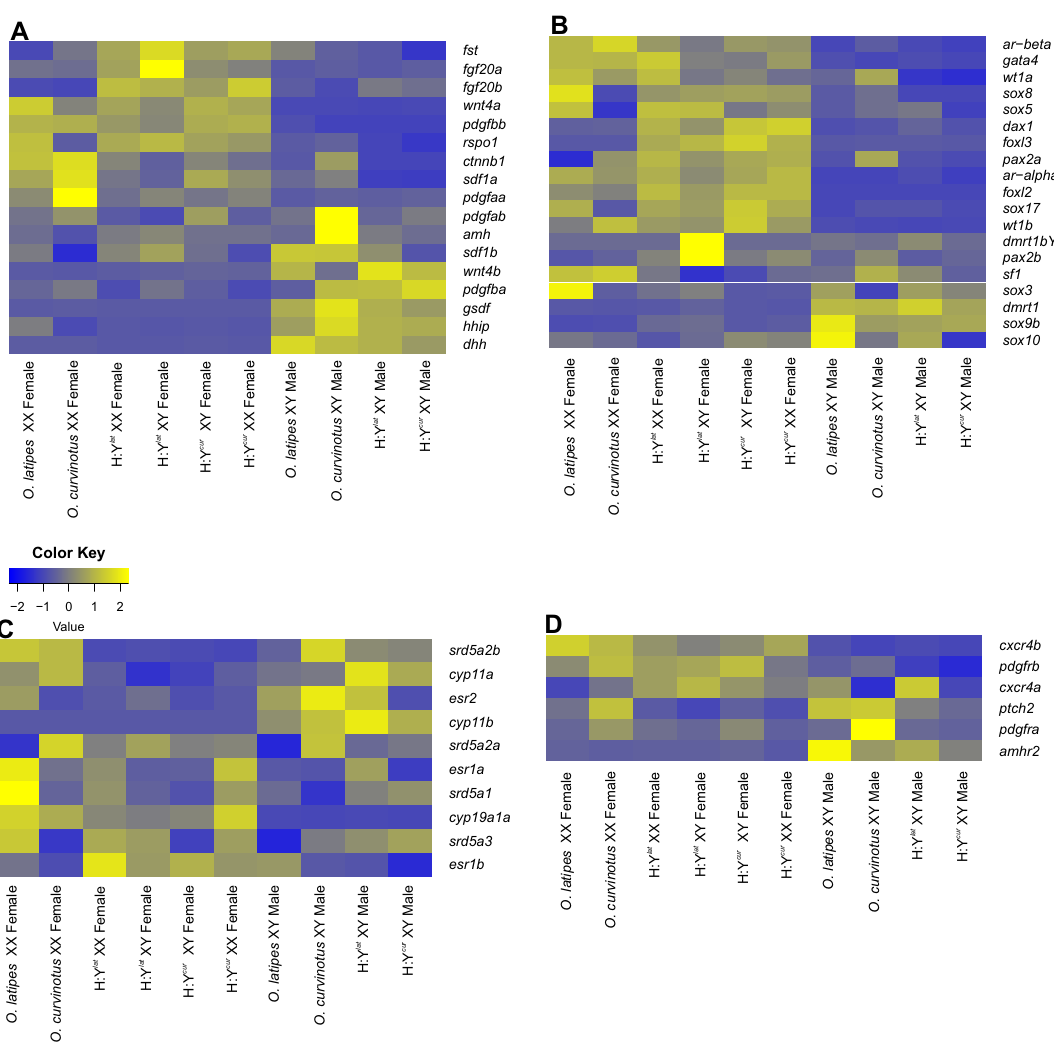
Figure 2. Heatmaps of sex-related genes in male and female adult gonads of parental and hybrids. Growth factors ( A ), transcription factors ( B ), steroidogenic enzymes and receptors ( C ), and growth factor receptors ( D ). Transcripts with higher expression levels are in yellow, while lower expression is in